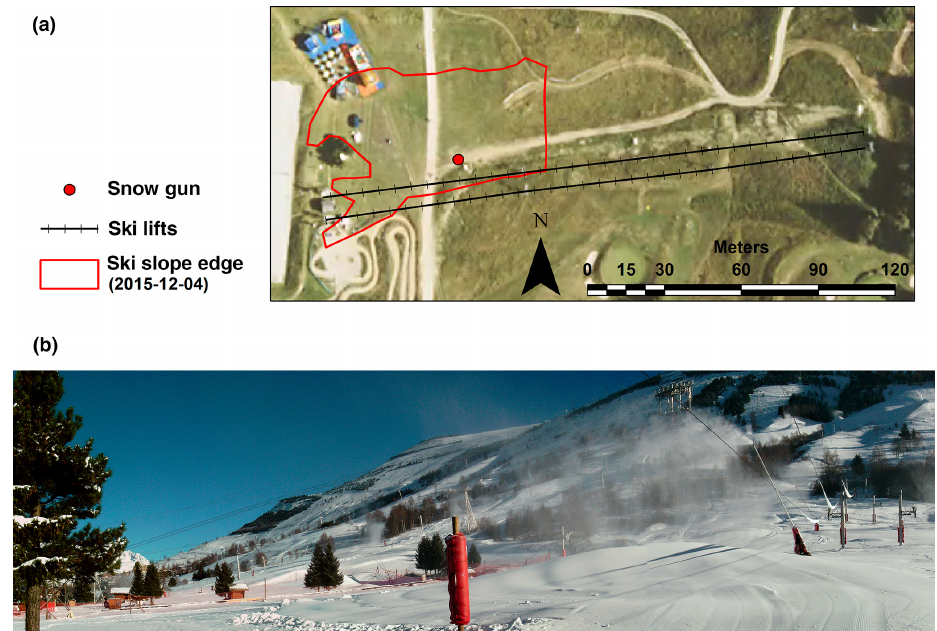
Figure A1. (a) Observations site from above. Temporary structures in the top left corner were not present during the winter season. (b) A pic- ture of the production session on 27 November 2015. MM snow can be seen on the tree and on the cables of the ski